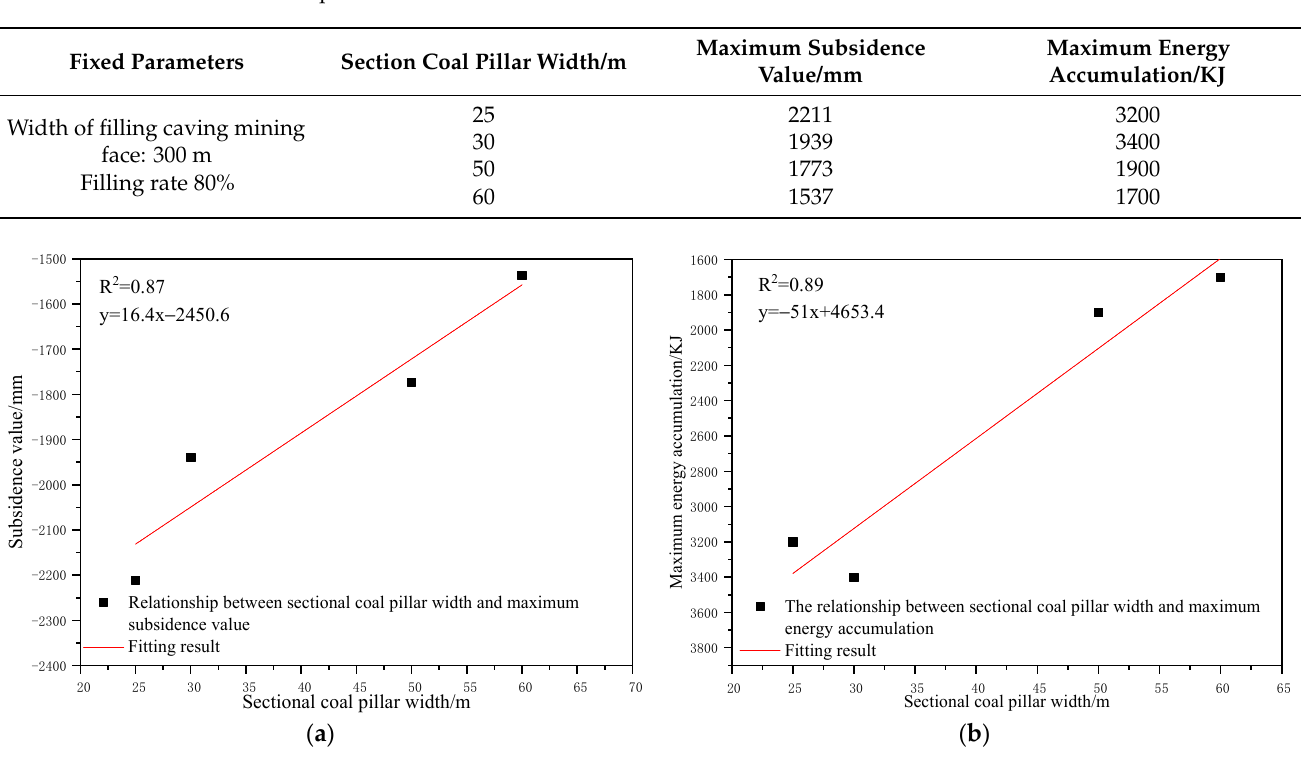
Table 12. Statistical table of surface subsidence and energy polling extreme values in different section pillar scale.